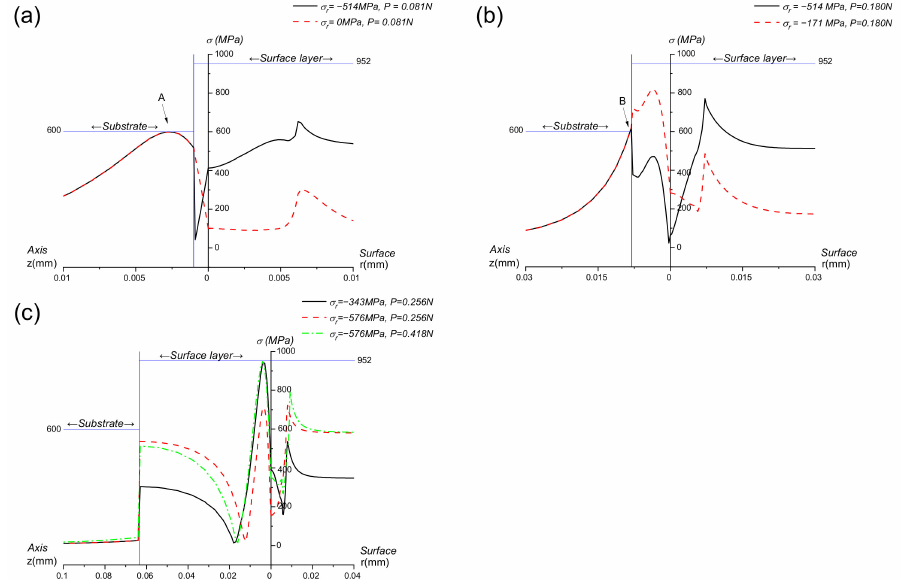
Figure 11. Contact stresses at the axis of symmetry and the surface with different surface layer thicknesses and different residual stresses. The parameters are E s = 200 GPa, E l = 400 GPa, Y s = 600 MPa, Y l = 952 MPa. ( a ) t / R = 0.001. ( b ) t / R = 0.008. ( c ) t / R =